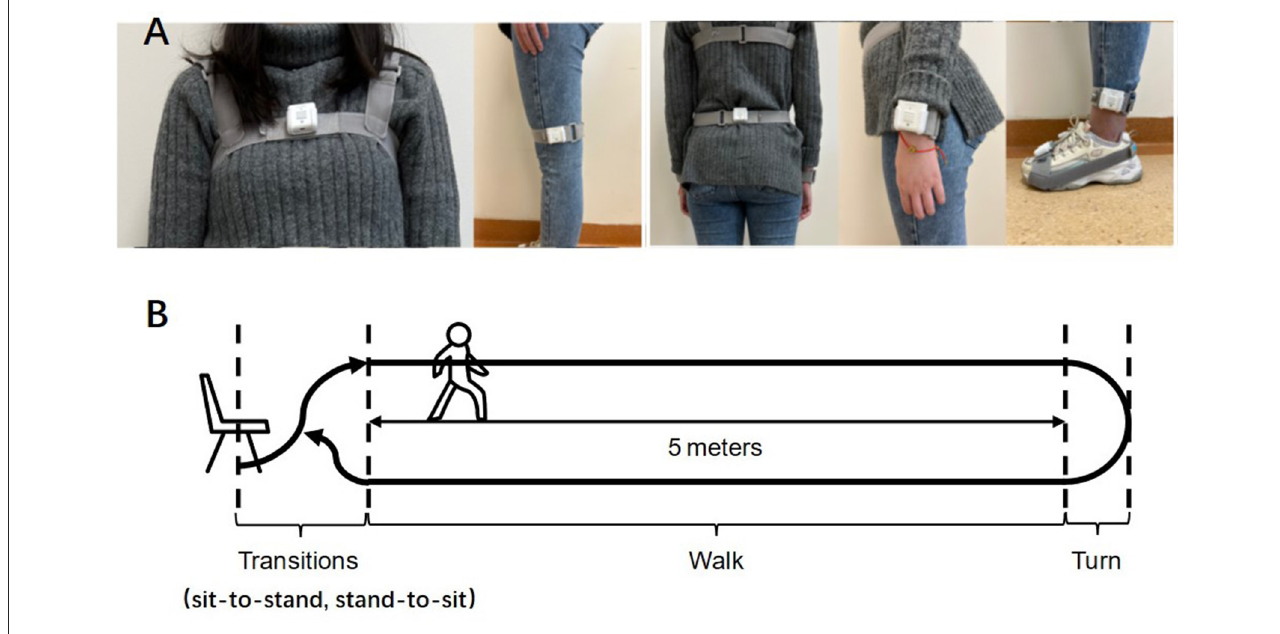
FIGURE1 (A, B) The front, back and side view of wearable device and the process of motor task.